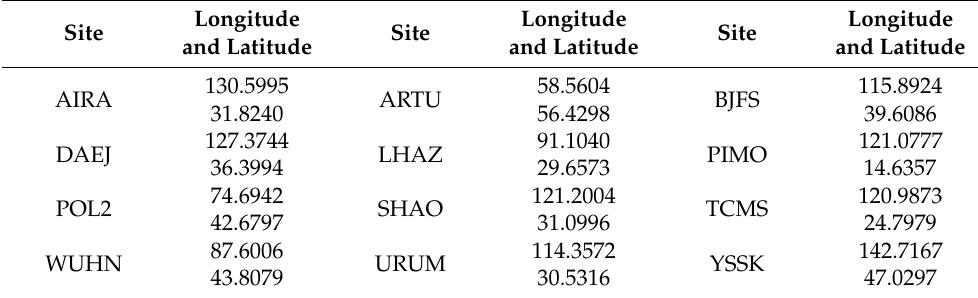
Table 2. 12 IGS sites used in CORS network calculation the southeast Zhejiang